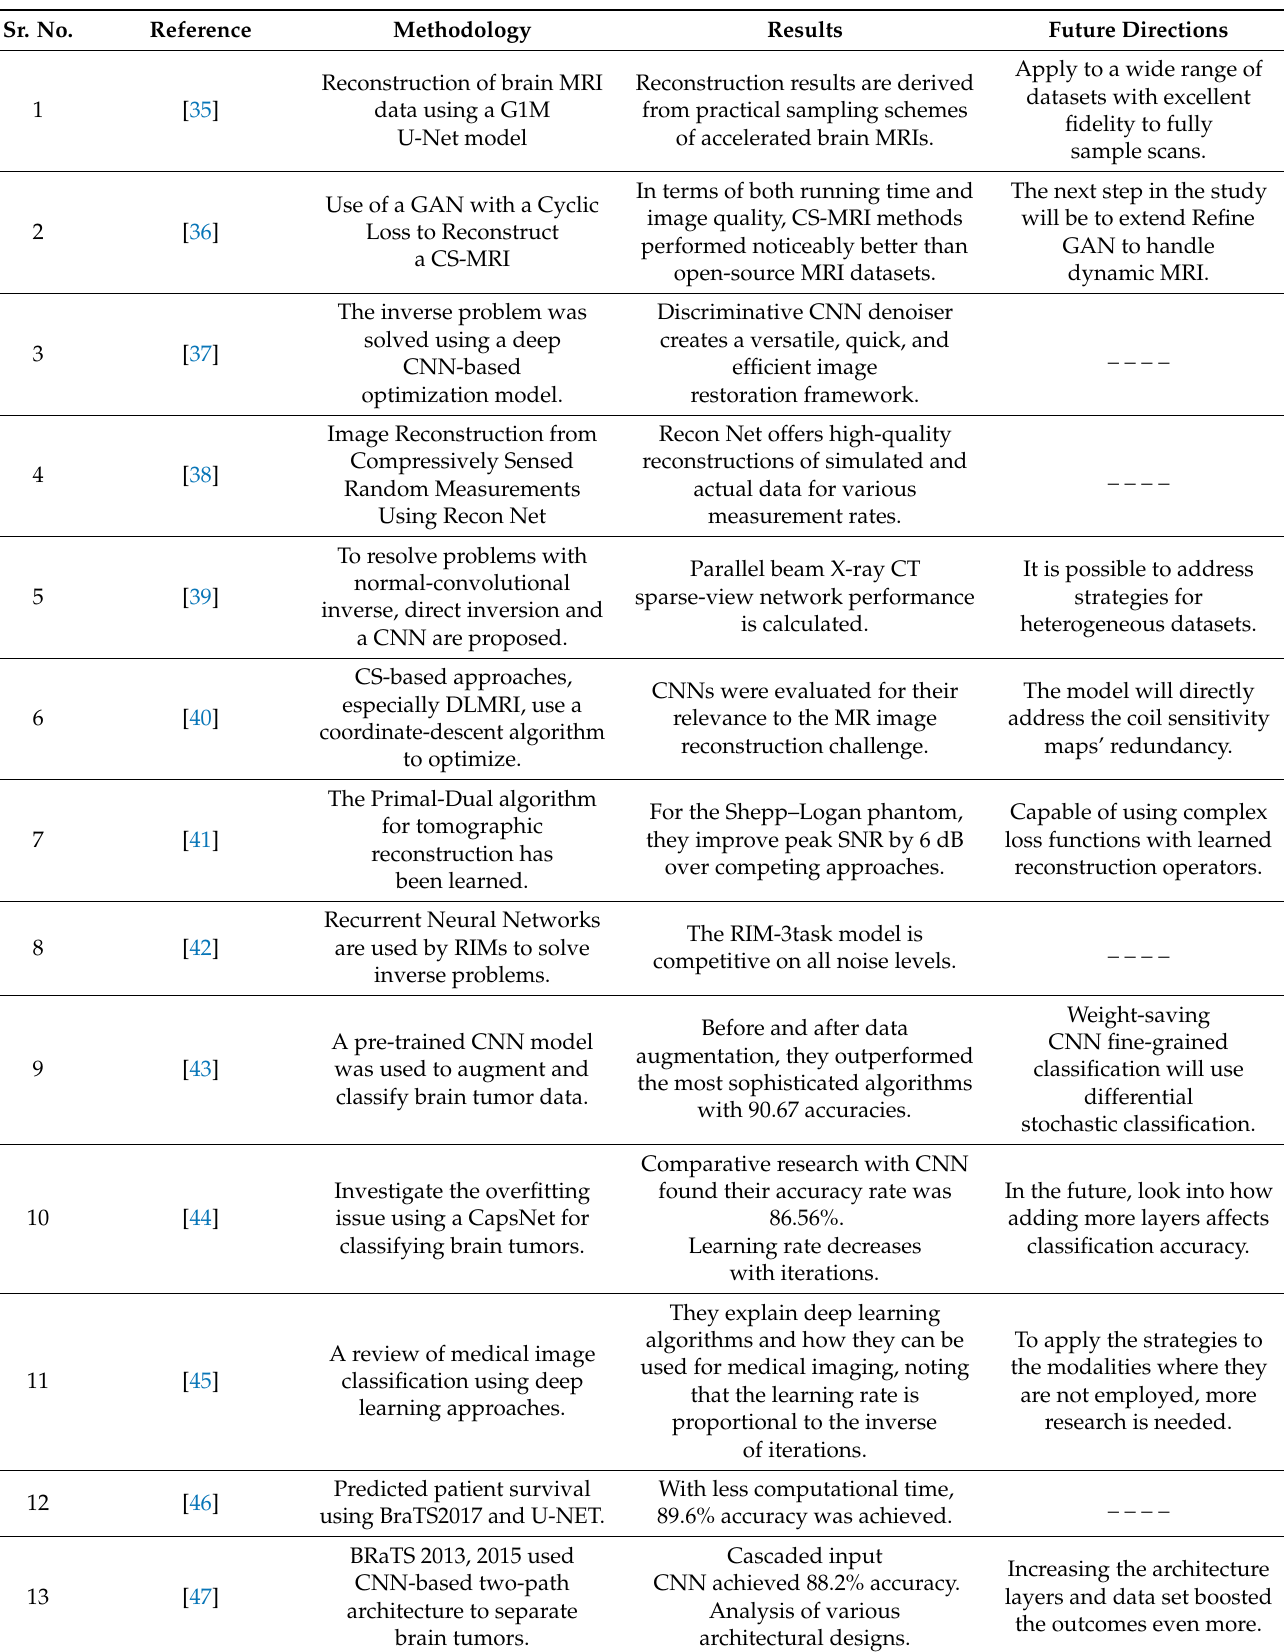
Table 1. A summary of different articles regarding deep learning-based and other models for MRI